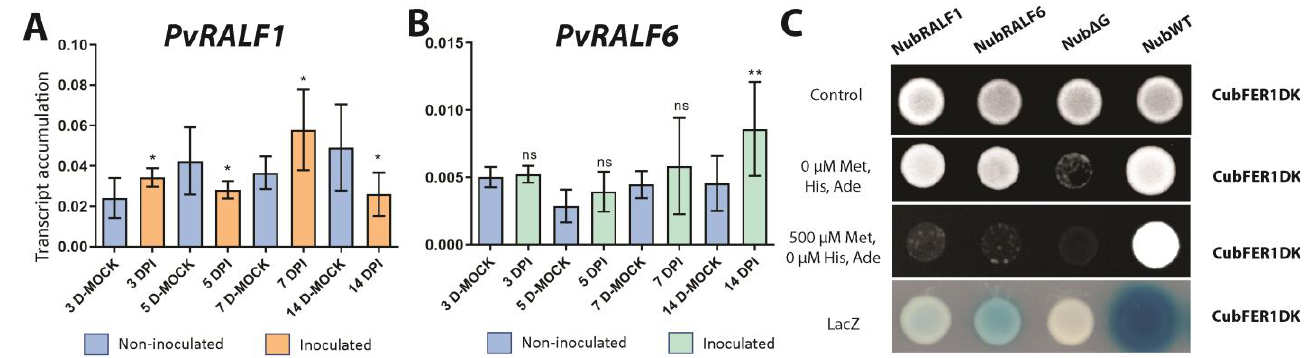
Figure 2. PvRALF1 and PvRALF6 respond to rhizobial inoculation at 0 mM and the corresponding peptide products interact with PvFER1 ∆ K. Accumulation levels of PvRALF1 ( A ) and PvRALF6 transcripts ( B ) in inoculated and non-inoculated wild-type roots under 0 mM nitrate. Data are means ± SD ( n = 9). A non-parametric Mann–Whitney test was used to assess significant differences. * p < 0.05, ** p < 0.01; ns = not significant. The transcript accumulation of the IDE gene was used as a reference. ( C ) Split-ubiquitin system assays showing interaction between PvFER ∆ K and PvRALF1 or PvRALF6. NubWT and NubΔG were used as positive and negative controls, respectively. The experiments were repeated twice with similar results.